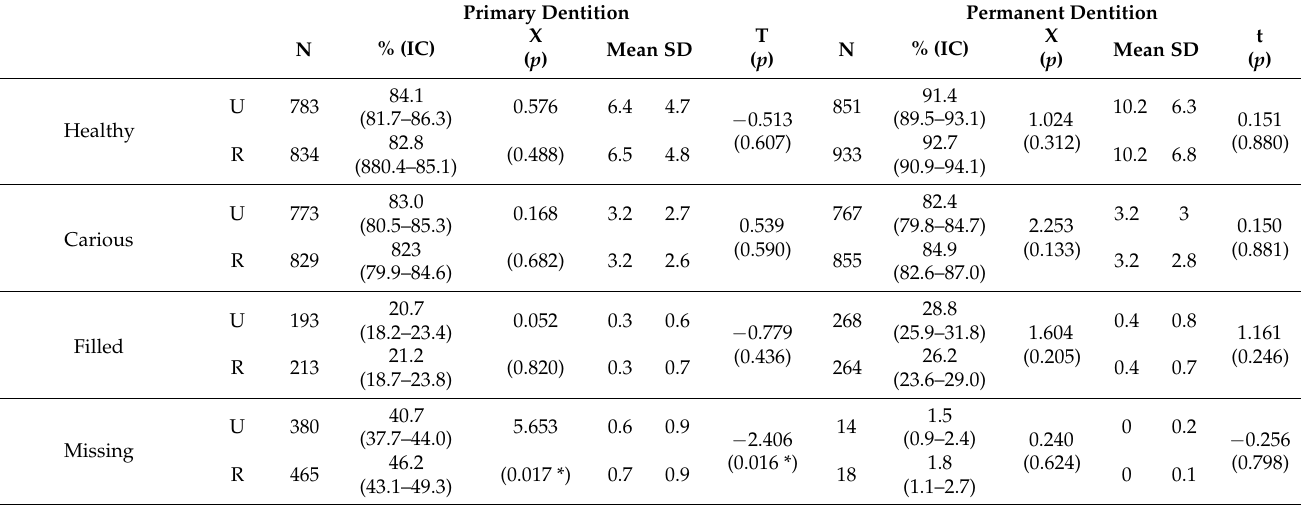
Table 3. Caries experience and treatment needs according to urban/rural